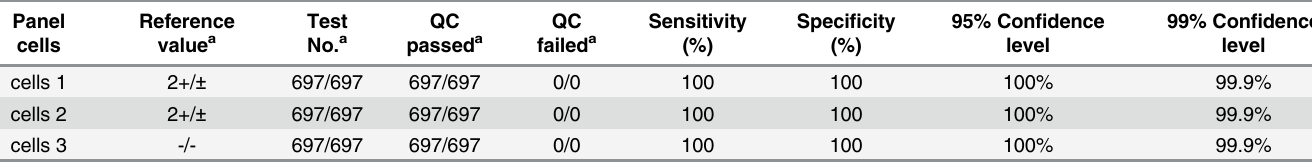
Table 2. Analysis of IQC for irregular antibody screening. Panel